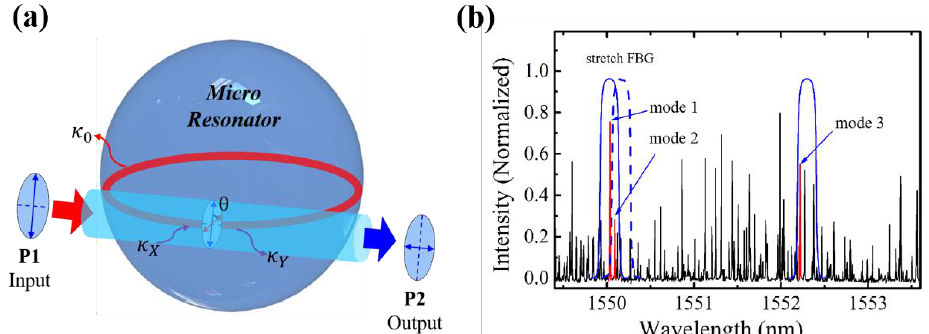
Figure 1. ( a ) Schematic diagram of the polarization conversion based on orthogonal modes coupled a WGM resonator, including P1 and P2, which are the polarizers. ( b ) The principle of the mode selection brought by the FBG. The black line is the spectrum of the drop mode of the polarization conversion device, the blue inverse U-shape lines indicate the reflection spectrum of FBG, and the red modes 1, 2, and 3 are the WGMs selected by the